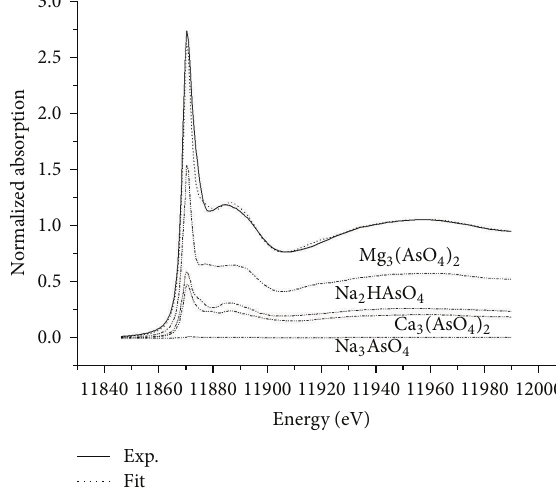
Figure 6: Near edge spectra of the cement paste compared with a sum of 55% Mg 3 (AsO 4 ) 2 , 25% Na 2 HAsO 4 , 19.4% Ca 3 (AsO 4 ), and 0.5% Na 3 AsO 4 . The small differences between the two spectra are likely due to the disordered